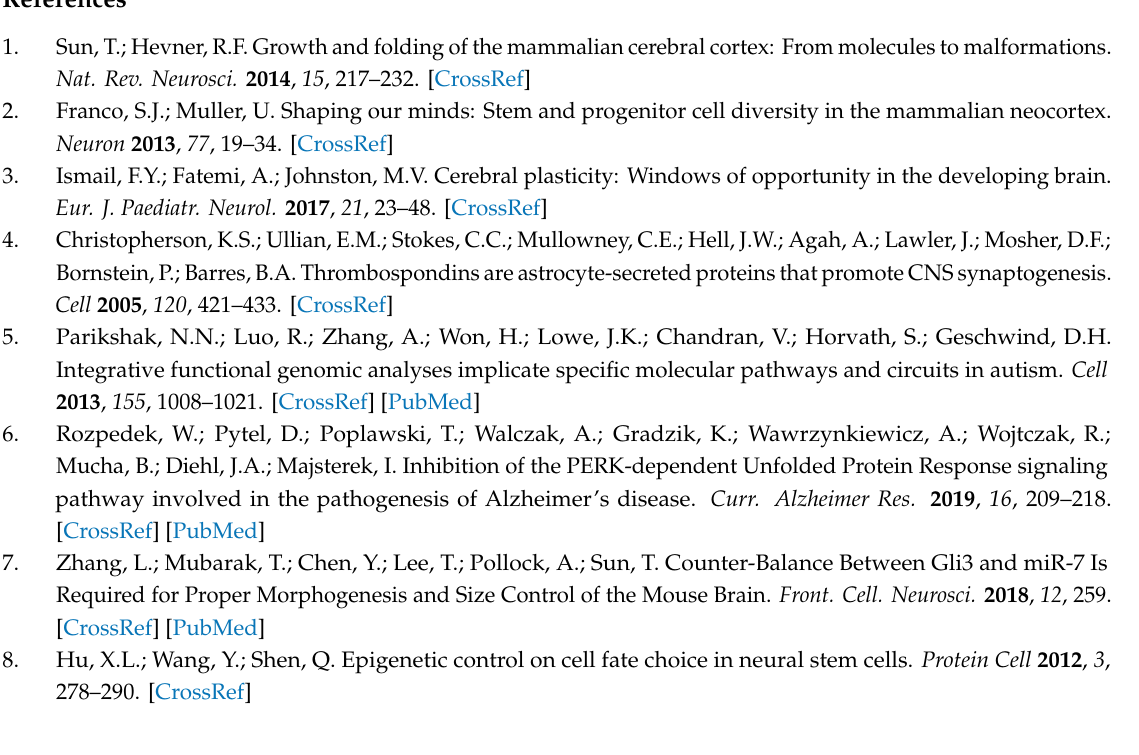
Figure S1: The Pearson correlation of read counts, Figure S2: The status of m6A summits and sequencing replications, Figure S3: The correlation between the up- / down-regulation of RNAs and the positions of m6A, Figure S4: The status and distribution of temporally methylated RNAs counted in each chromosome, Figure S5: The distribution of m6A summits in relative position of a gene, Figure S6: The collection of the most impacted KEGG terms, Figure S7: E-SMRs (NSC and 3’ UTR restricted) involved in the hippo signaling pathway and Hedgehog signaling pathway, Figure S8: P-SMRs (NSC and 3’ UTR restricted) regulate multi chemical signals transport via relative synapse pathway, Figure S9: Three examples for status of m6A-methylation in genes from triplicated samples Table S1: The collection of all detected methylation RNAs in E12.5-E13 and P14 cortices, respectively, Table S2: The GO and KEGG analysis of E-SMRs, P-SMRs and CMRs (NSC and 3’ UTR restricted), Table S3: The numbers of m6A site in targeted genes shown in Figures 4 and 5, Table S4: Genes encoding transcript factors expressing in cortex, temporal- and spatial-specifically methylated, Table S5: Pathogenic genes of nervous-systamic disorders with temporal- and spatial-specific methylation form, Table S6: The IGV performance of all risk genes of brain disorders with temporal-specific methylation in NSC and 3’ UTR region. Author Contributions: T.S. and L.Z. conceived and designed the study. L.Z. performed major experiments and analyzed the data. K.D. and J.W. assisted the experimental performance. Y.N. performed the transcriptome analysis. L.Z., T.L. and T.S. interpreted the data and wrote the paper, and all authors provided feedback. All authors have read and agreed to the published version of the